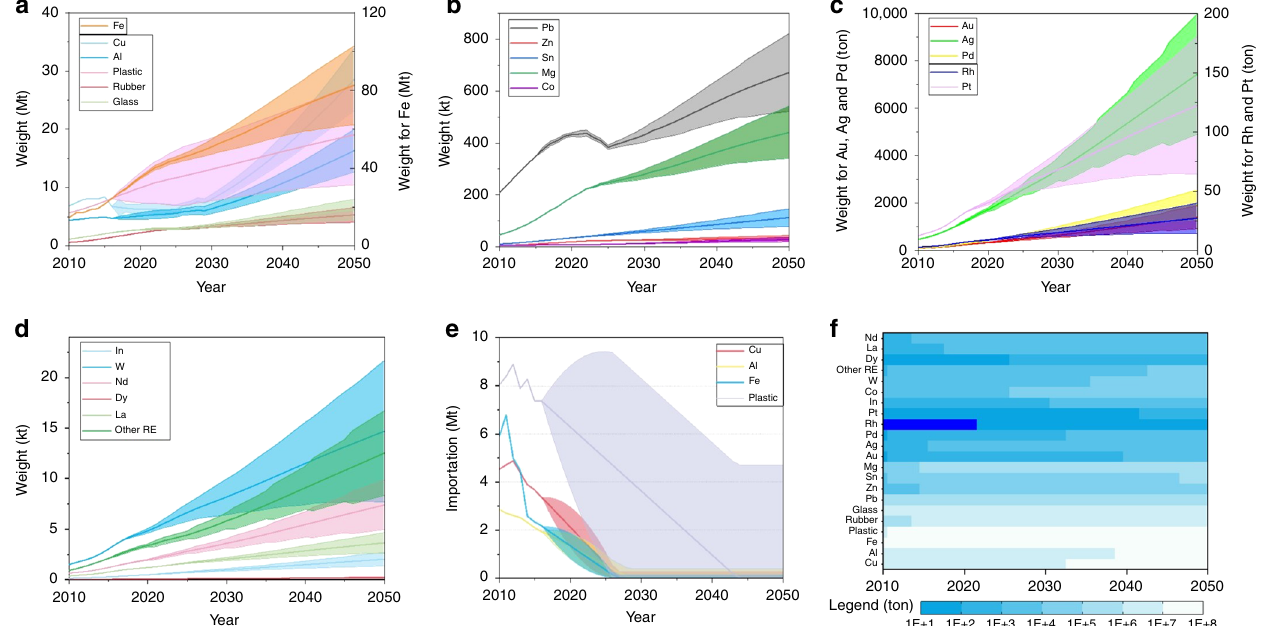
Fig. 3 Resources weight in yearly-generated AM. a base material. b Pb, Zn, Sn, and Mg materials. c precious metals. d rare metals and rare earths. e imported resources. f average resource map. Note: Resources cover the base material (like valuable metal, plastic, and rubber), precious metals, rare metals, and rate earth (RE) elements. The imported resources primarily comprise Cu, Al, Fe, and plastic. The shadowing area indicates the range. For the color map of Rh, deep blue color indicates no data.